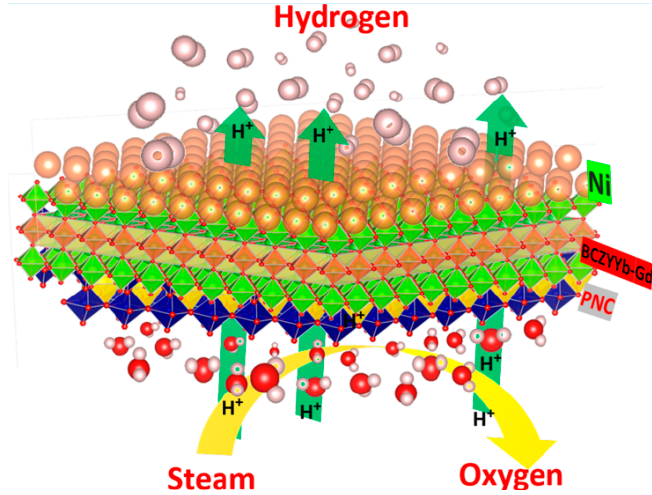
Figure 11. Representation of the solid oxide electrolysis cell [183].